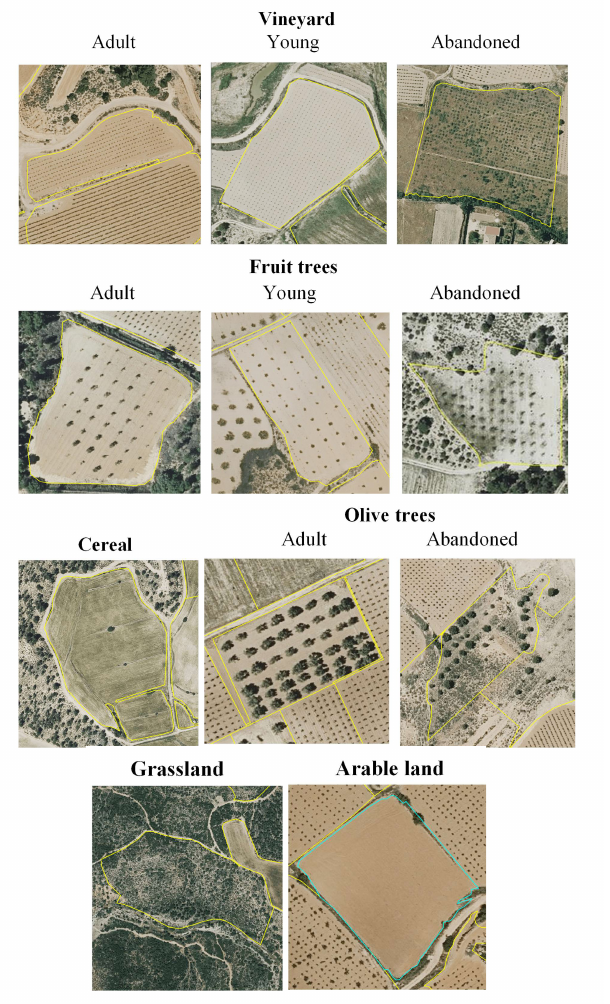
Figure 2. Examples of orthoimage subsets of parcels with the classes defined for crop classification and crop